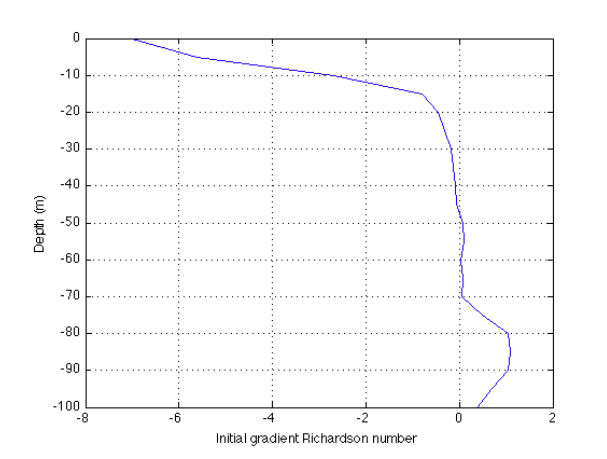
Fig. 8. Test 2: initial gradient Richardson